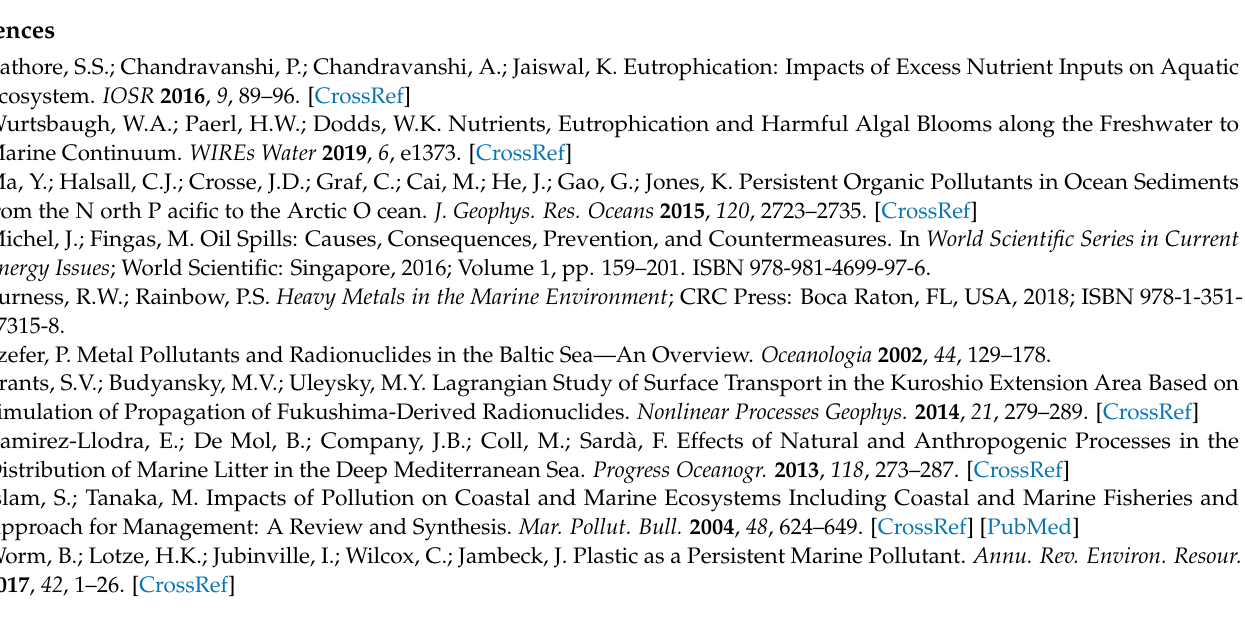
Figure A4. Daily backward finite-time Lyapunov exponent (FTLE) application in the area of the East China Sea oil spill using the altimetry product in near-real-time. The black asterisk in all panels indi- cates the location where the Sanchi tanker sank. The red patch represents the daily evolution of Sanchi leaked oil path from the 17th to 20th of January 2018 in panels ( a – d ), respectively. The gray-scaled filament-shaped fronts in the background represent daily Lagrangian fronts (FTLE computation using Altimetry Copernicus product). Dark fronts reveal highly attractive and stretching zones. In this case, the sharpest front is related to the core of the Kuroshio Current. These fronts are even more prominently observed with the backward FSLE technique. The altimetry-derived velocity product is also available at E.U. Copernicus Marine Service Information (CMEMS). Daily surface observations of the global ocean are used in near-real-time (NRT), with L4 processing level and a spatial resolution ac- counting for 0.25 ◦ × 0.25 ◦ (product id: